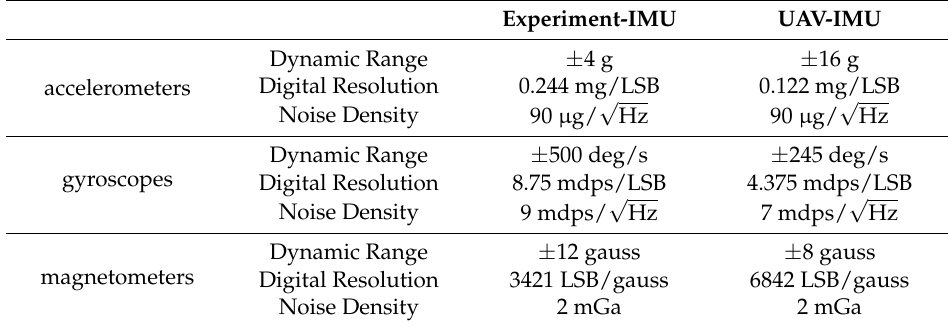
Table 1. Performance comparison of accelerometers, gyroscopes, and magnetometers contained in the experimental IMU and UAV-IMU.